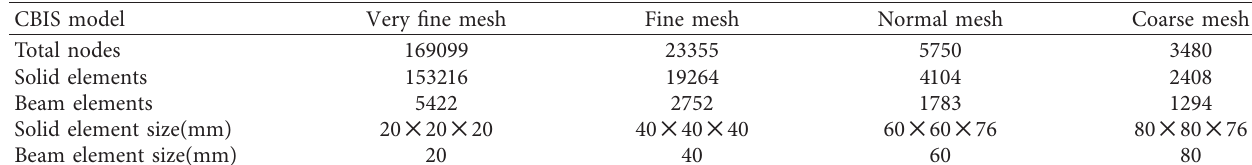
Table 4: Mesh data for the CBIS model.